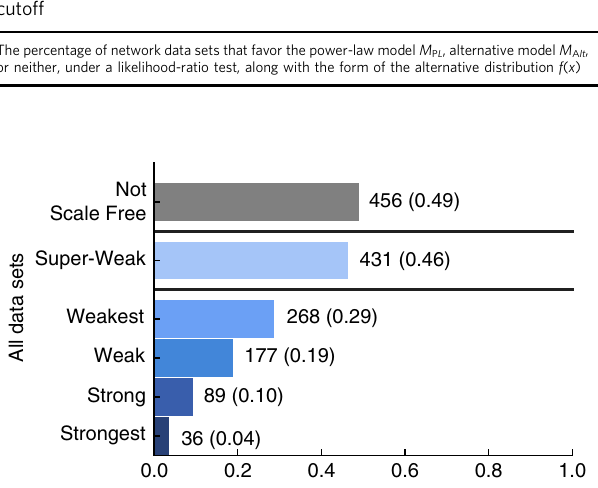
Fig. 4 Proportion of networks by scale-free evidence category. Bars separate the Super-Weak category from the nested de fi nitions, and from the Not Scale Free category, de fi ned as networks that are neither Weakest or Super-Weak